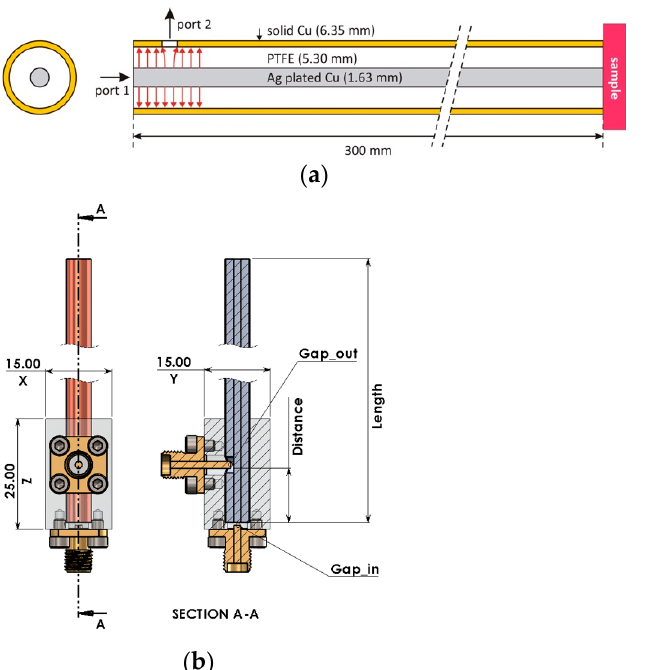
Figure 1. Mechanical construction of the two-port coaxial harmonic resonance probe. ( a ) Coaxial resonator formed from an open-ended coaxial cable (RG401, with material diameters shown), and ( b ) 3D CAD model of the complete coaxial resonant probe with break view in the length of coaxial cable. Cross-section A-A shows the detailed coupling structure inside the aluminum fixture that hosts two SMA connectors and the RG401 cable (all units in mm).